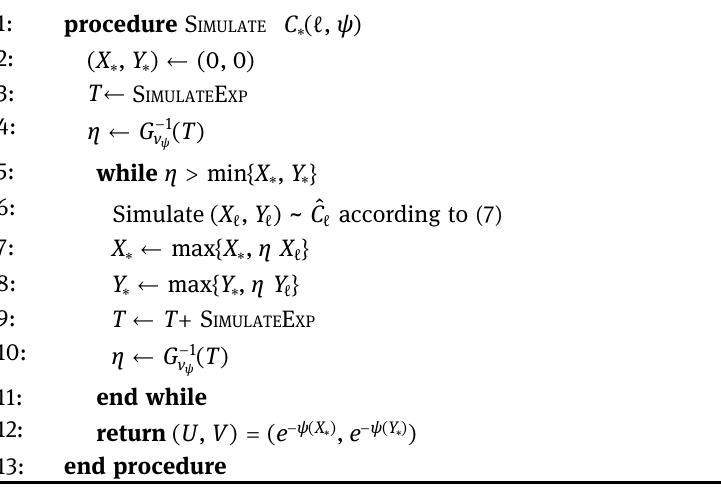
Algorithm 2 . Simulation of